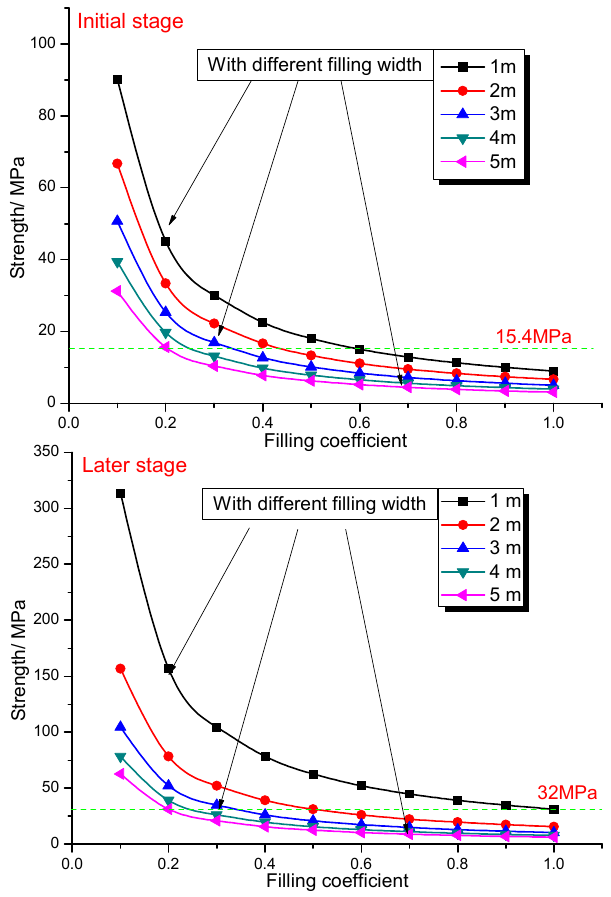
Figure 13. Theoretical strength for different width ratio matching.